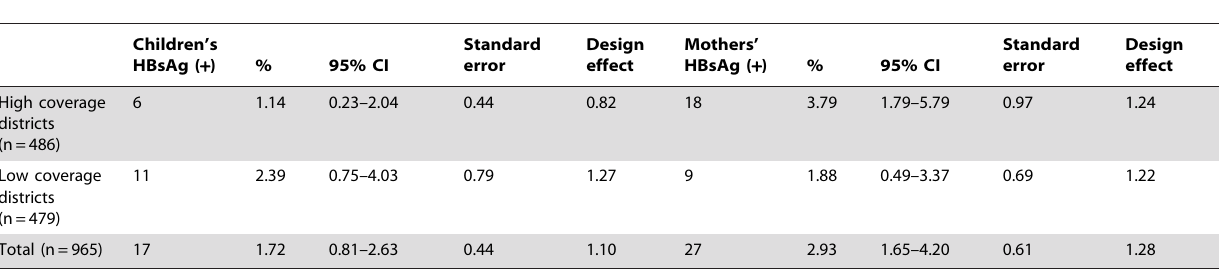
Children’s HBsAg ( + ) % 95%